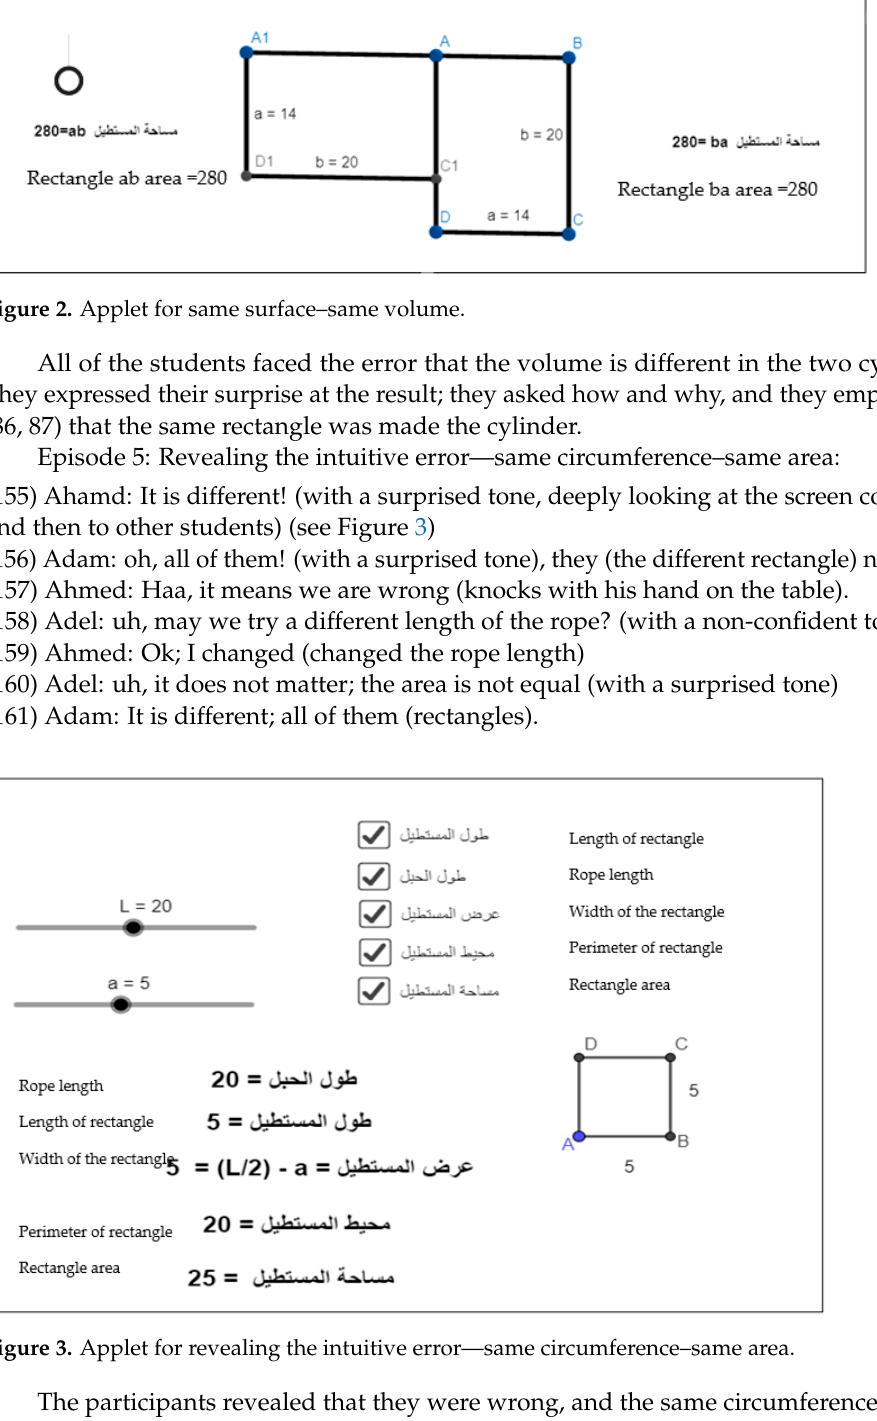
Figure 4. Applet reveals the intuitive error-dynamic referent in volume. Episode 6 showed that all students (210, 211 and 212) think it is strange to obtain different volumes. In this phase, we identified several indicators and signs of non-comfortable and confusing situations by revealing the errors in the three tasks. These included a loud voice or a sad tone of voice, physical movements such as moving closer to the computer screen and other physical indicators such as opening the mouth and putting a hand on the head or the face. For example, in Episode 4, we identified surprising and sad tones while revealing that the two cylinders’ volumes are different. Adel (85) spoke in a low